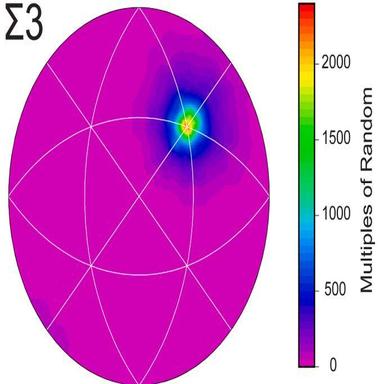
GB plane distribution for Σ3 boundaries of determined by the fiveparameter statistical stereological analysis of solutionised and aged Alloy 1.